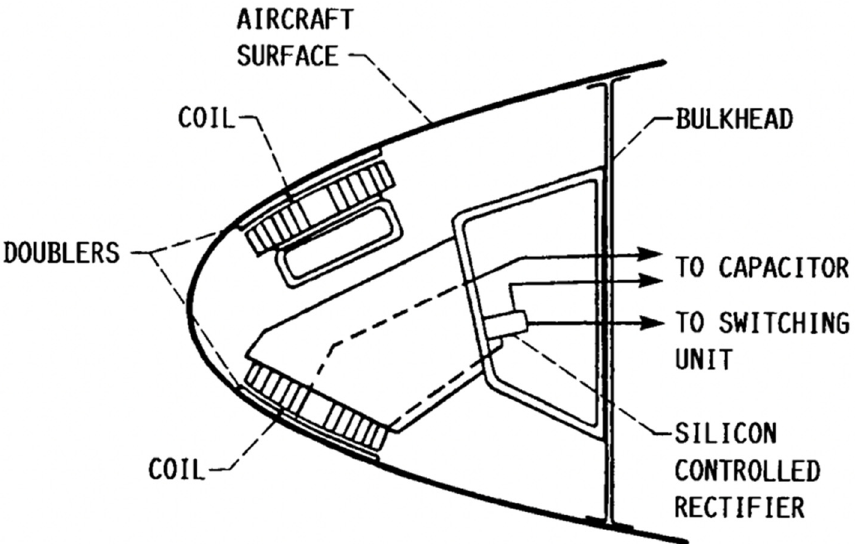
Figure 11. Schematic of EIDI (obtained from [122]).